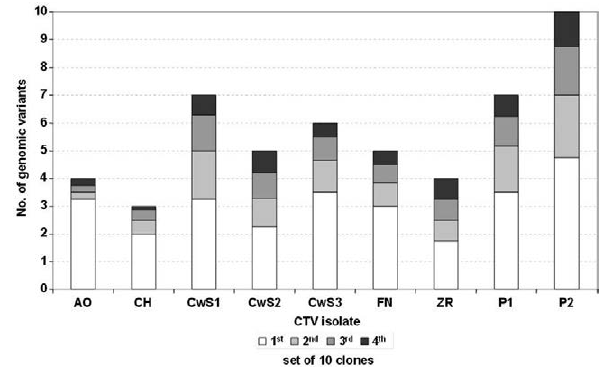
Figure 1. The number of genomic variants detected in a 1 st set of 10 clones of nine Citrus tristeza virus isolates based on the results of the SSCP analysis and the number of additional variants detected in incremental sets of ten clones averaged over 24 possible sampling orders of four sets.